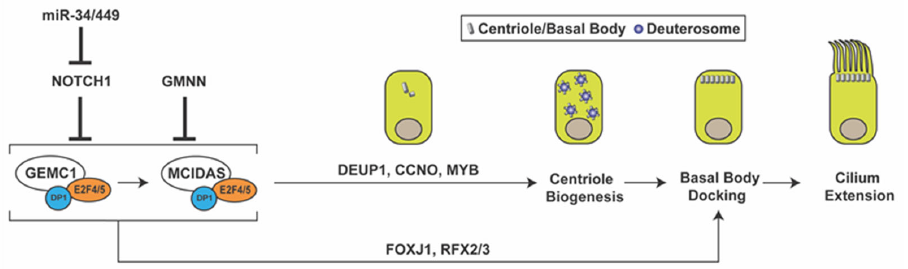
Figure 1. Multiciliated cell differentiation. Key factors and events for MCC differentiation are de ‐ picted. Repression of Notch signaling by miR ‐ 34/miR ‐ 449 triggers MCC differentiation. GEMC1 acts in a complex with E2F4/5 and DP1 to turn on MCIDAS and other ciliary genes necessary for centriole amplification, basal body docking, and cilium elongation. GMNN functions as an inhibitor of GEMC1 and MCIDAS. GMNN, geminin; GEMC1, geminin coiled ‐ coil domain ‐ containing protein 1; DEUP1, deuterosome assembly protein 1; CCNO, cyclin O; FOXJ1, forkhead box J1. Downstream of Notch inhibition, the MCC differentiation gene regulatory network is controlled by the coiled ‐ coil Geminin family proteins Geminin (GMNN), Geminin coiled ‐ coil domain ‐ containing protein 1 (GEMC1), and MCIDAS (also known as multicilin or IDAS) [38–46]. Both GEMC1 and MCIDAS are master regulatory proteins that are nec ‐ essary and sufficient for MCC differentiation [43,47]. Upon forming a ternary complex with the cofactor DP1 and transcription factors E2F4/5, GEMC1 is able to activate expres ‐ sion of MCIDAS and other downstream ciliary genes. MCIDAS also acts as a transcrip ‐ tional activator by forming a complex with DP1 and E2F4/5 to stimulate gene expression essential for centriole biogenesis. Early multiciliogenesis factors that are downstream of GEMC1 and MCIDAS include deuterosome assembly protein 1 (DEUP1), MYB, cyclin O (CCNO), forkhead box J1 (FOXJ1), and RFX2/3 [41,43–45,48]. p73, another transcription